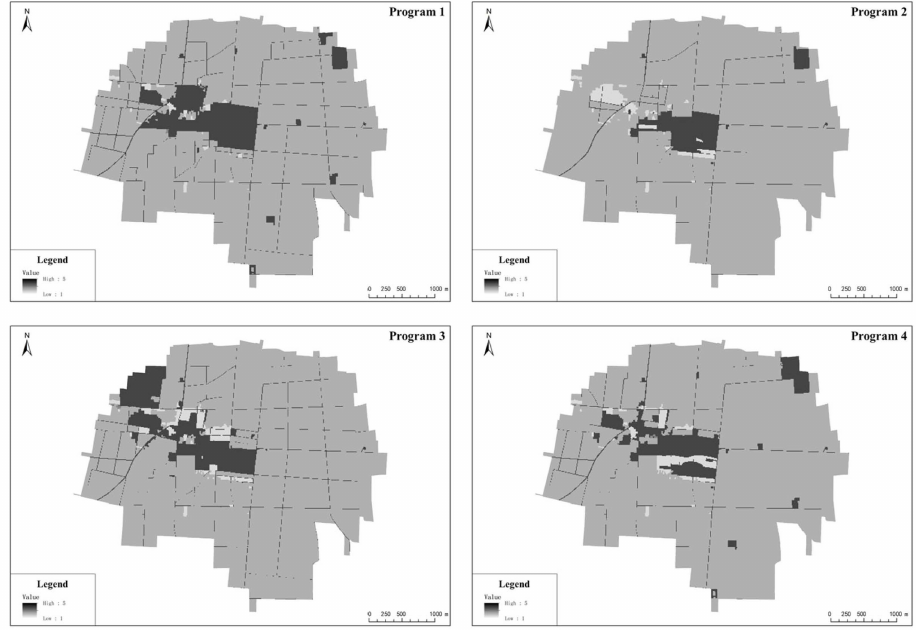
Figure 6. Comprehensive resistance surface of the alternative planning programs of Zepan